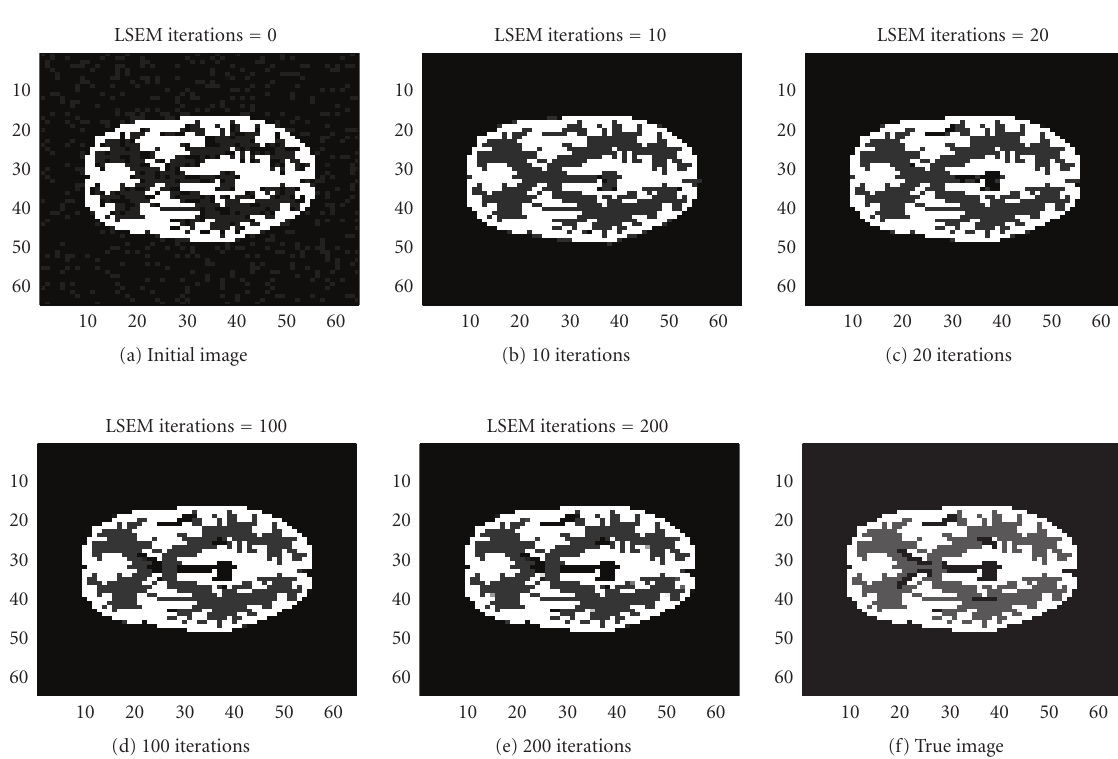
Figure 16: 64 × 64 segmented MRI slice of the